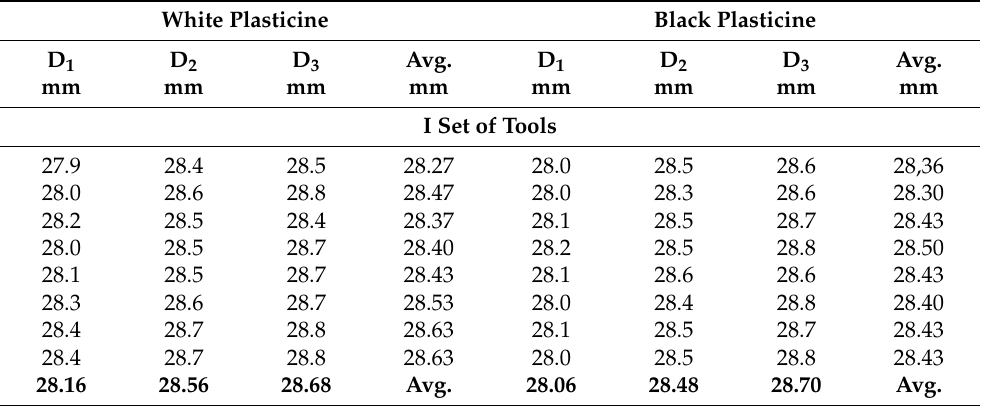
Figure 11. Samples made on type second tools: ( a ) black plasticine; ( b ) white plasticine. Laboratory tests were carried out three times for each type of tool. The balls obtained were then dimensioned and the results obtained were collected in the form of a table. Tables 5 and 6 show the results obtained from the measurement of one charge for each method and charge type. Table 5. Dimensions of model balls obtained by skew rolling—I set of tools: D1—groove diameter, D2, D3—average ball in two